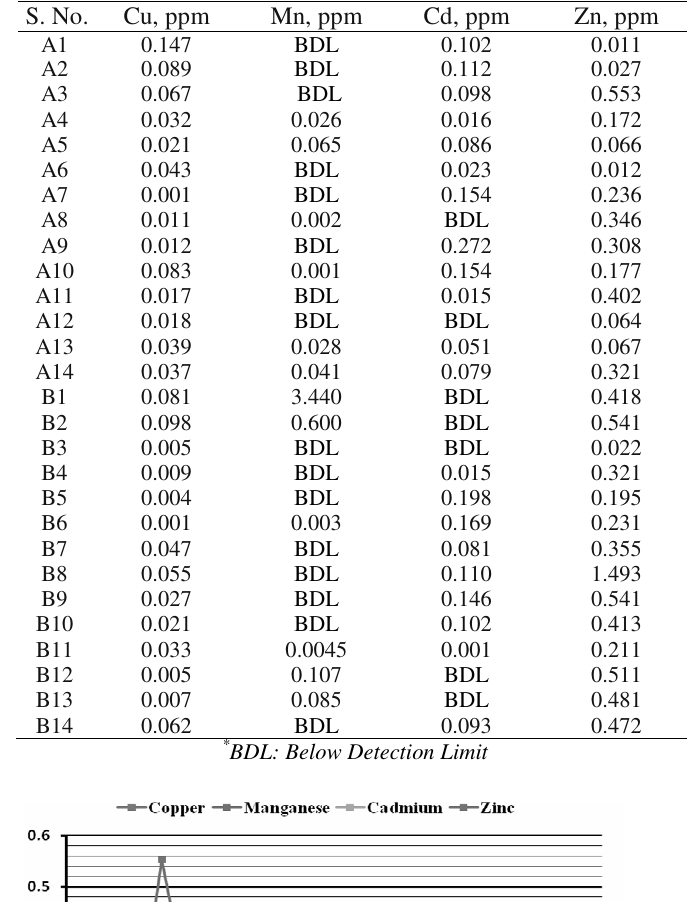
Table 2. Metal contents of groundwater in the tea garden belt of Darrang district.